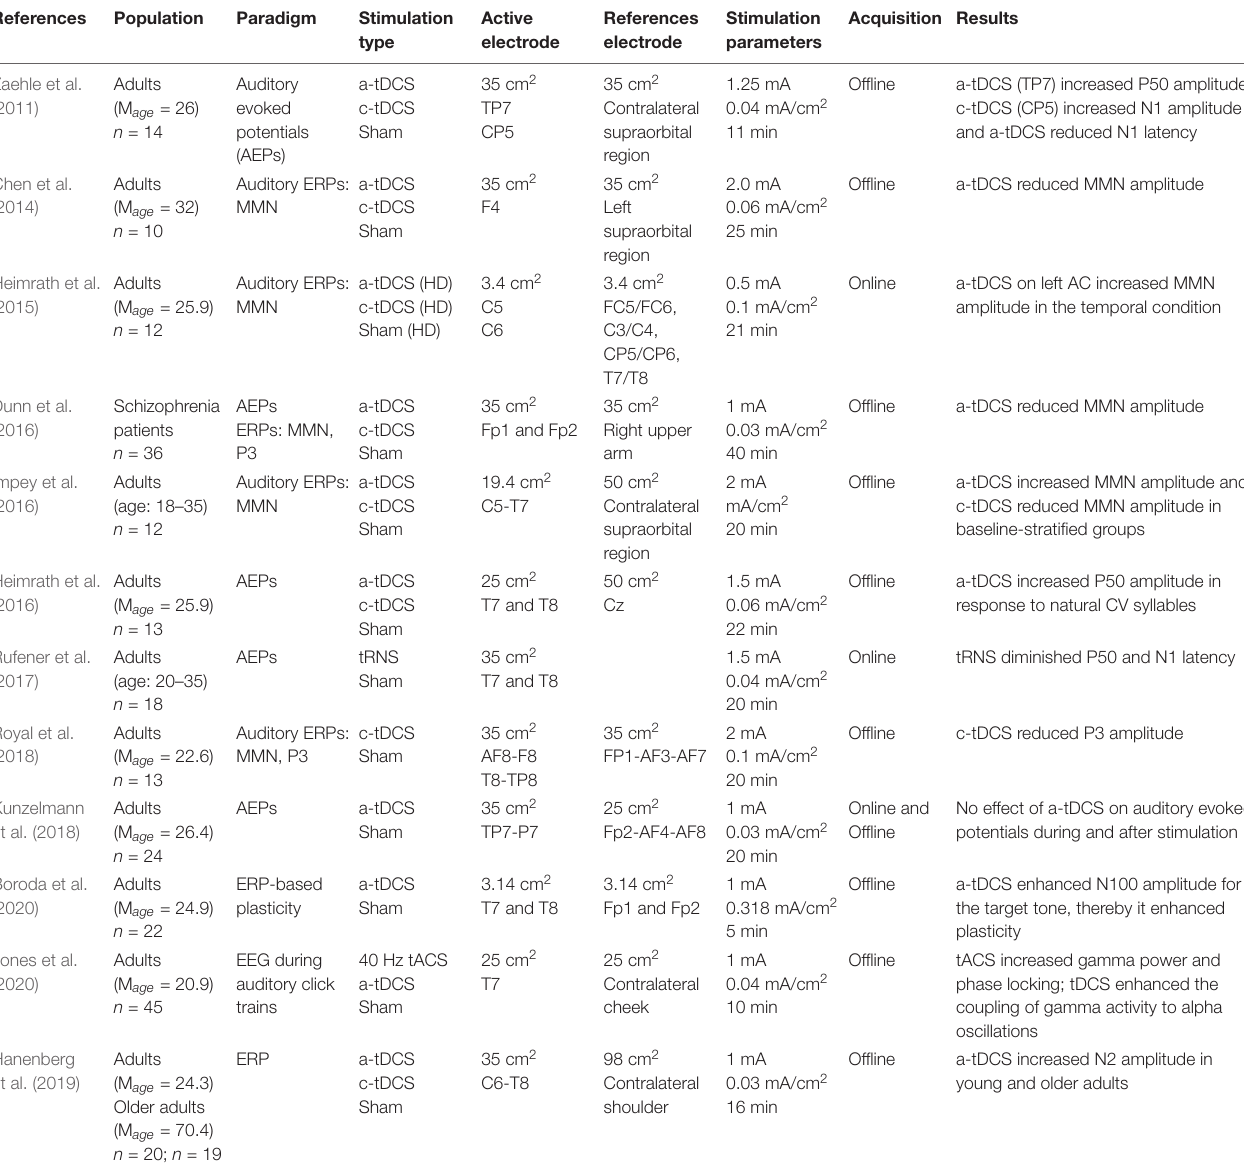
TABLE 1 | Auditory electrophysiological